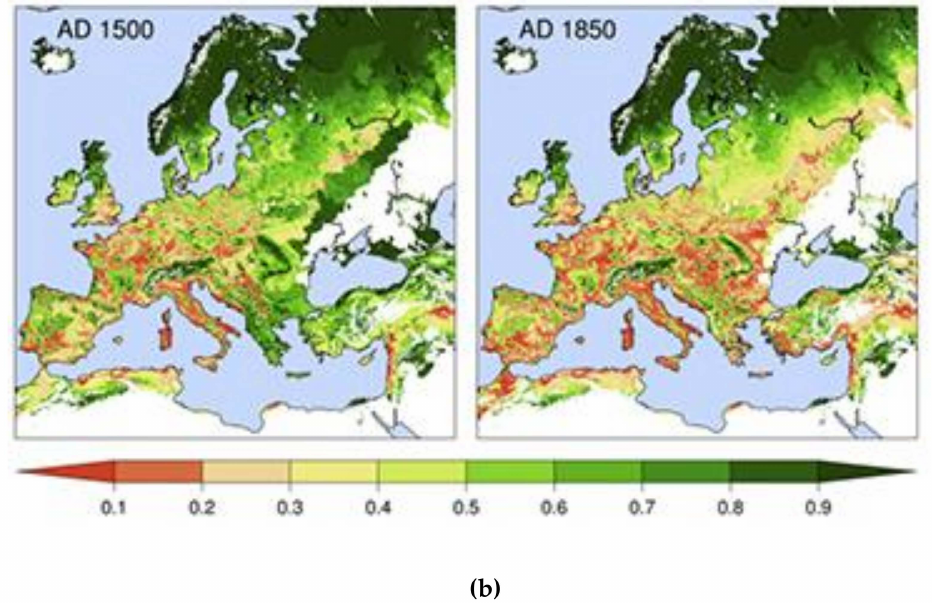
Figure 8. Relationships between air pollution and wood burning ( a ) carbon dioxide (CO 2 ) concentrations (in parts per million) from 1000 AD till 2000 AD [80]. ( b ) Historical forest clearance map from 1500 AD till 1850 AD